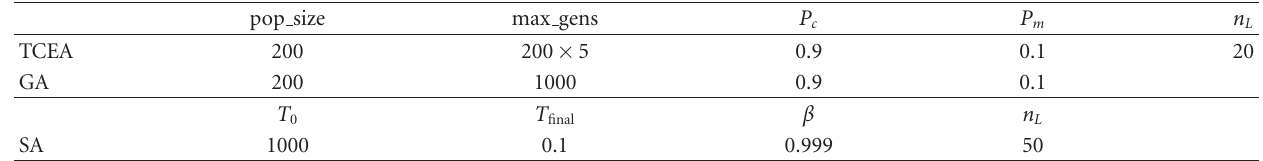
Table 3: Parameters setting for 3-level MLPS study case.